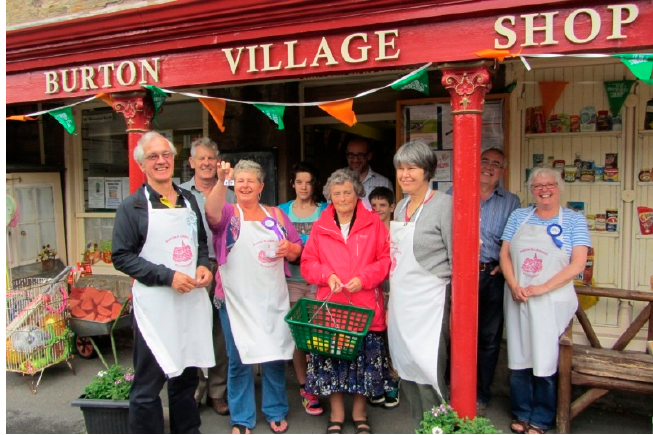
Figure 9. Community-owned village shop in Burton-on-Trent, Staffordshire, England [31].